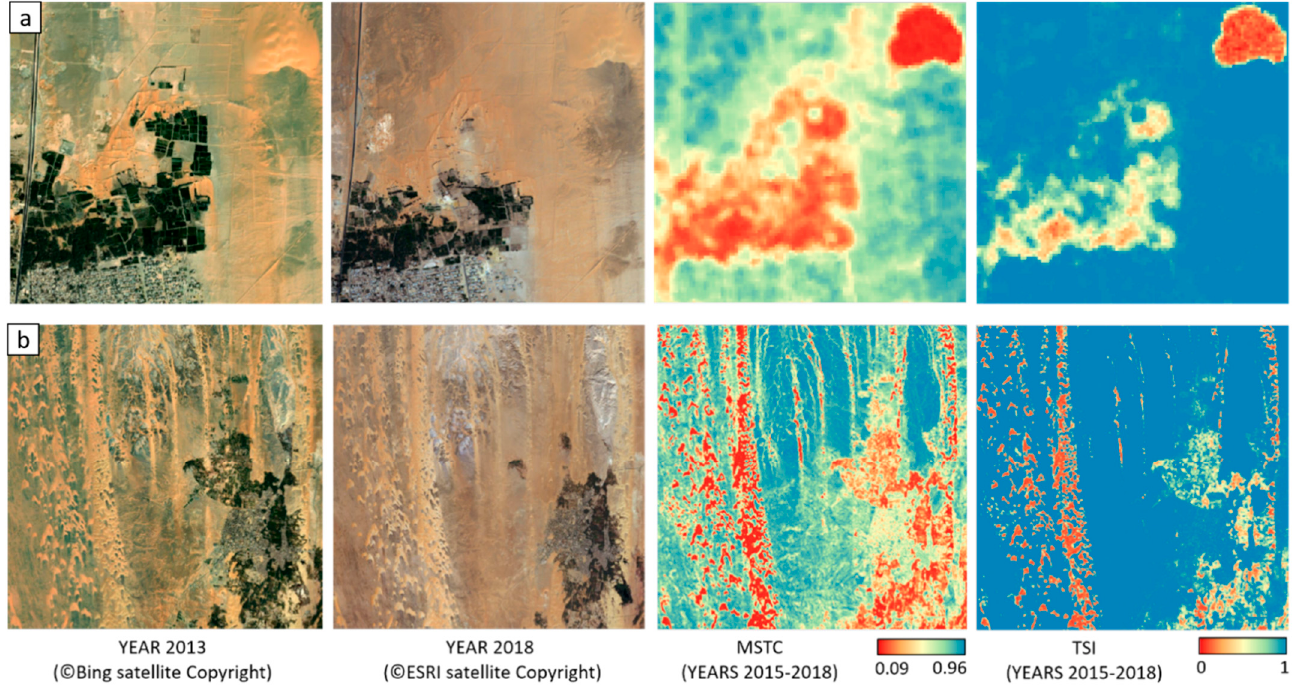
Figure 10. Detail of sub-areas a and b outlined in Figure 9: optical high-resolution satellite images referred to the years 2013 and 2018, Mean Short-Term Coherence (MSTC) and Temporal Stability Index (TSI) maps. Images identify cultivated fields and sandy dune structures as very unstable areas.